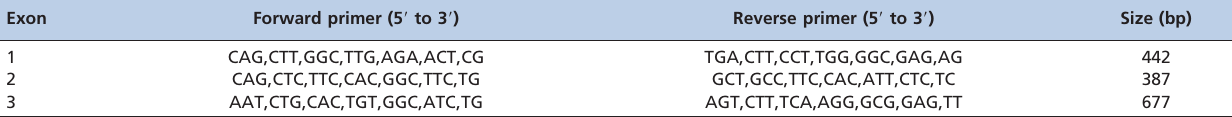
Table 1 - Primers to amplify the coding exons and exon-intron boundaries of